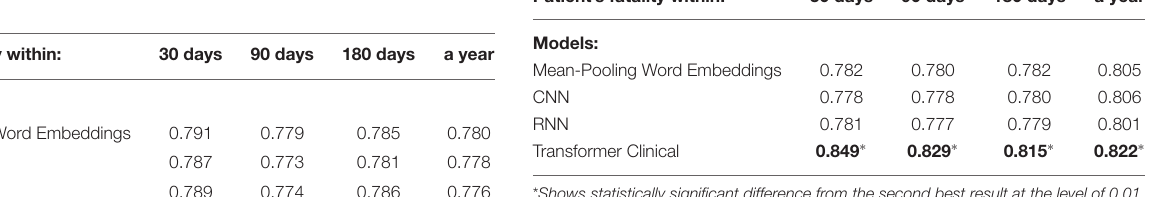
TABLE 9 | Comparison of the deep neural models on the tail portions (last 512 tokens) of discharge summaries for patient fatality prediction targets. Patient’s fatality within: